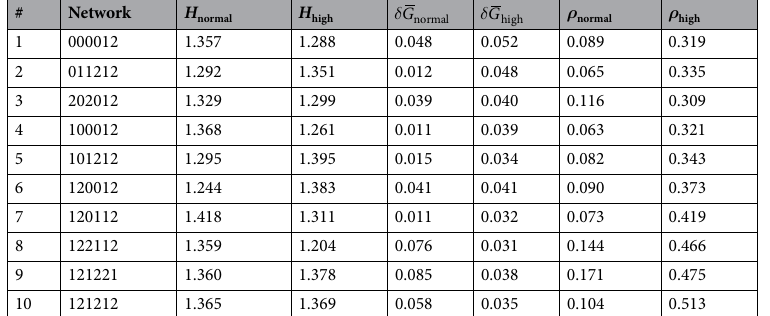
Table 1. Hormone consumption, glucose fluctuation, and inter-islet synchronization of ten effective networks under normal and high glucose